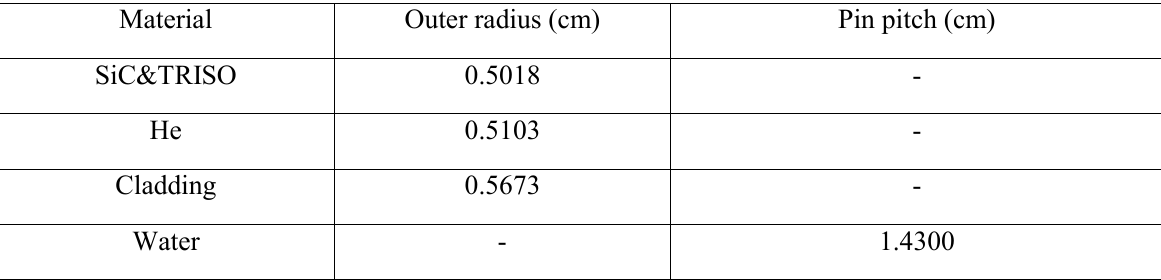
Table VIII Material and geometry of cases with the pin radius to be 0.5018 cm